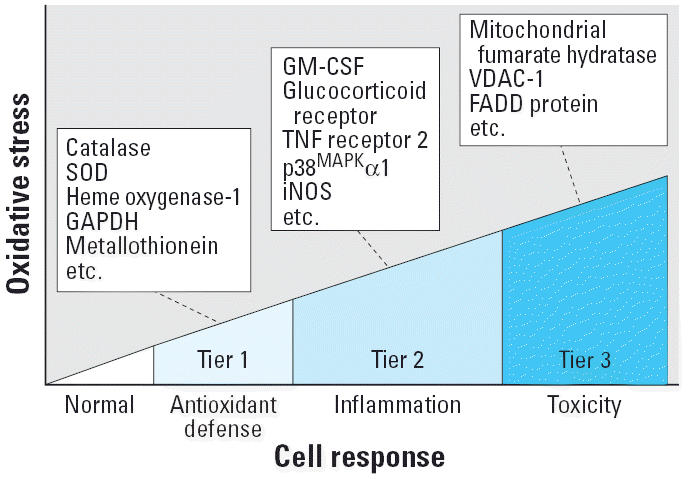
Hierarchical oxidative stress model in response to DEP exposure: proteome analysis of oxidative stress proteins shows a hierarchical response. Incremental doses of organic DEP extracts induce a series of incremental cellular responses that include increased antioxidant offense, inflammation, and cytotoxicity. At a lower level of oxidative stress (tier 1), antioxidant enzymes are induced to restore cellular redox homeostasis. At an intermediate level of oxidative stress (tier 2), newly expressed proteins often exhibit proinflammatory activity. At a high level of oxidative stress (tier 3), perturbation of the mitochondrial permeability transition pore and disruption of electron transfer result in cellular apoptosis or necrosis.Abbreviations: FADD, Fas-associating protein with death domain; GM-CSF, granulocyte-macrophage colony-stimulating factor; iNOS, inducible nitric oxide synthase; SOD, superoxide dismutase; TNF, tumor necrosis factor; VDAC-1, voltage-dependent anion channel 1.